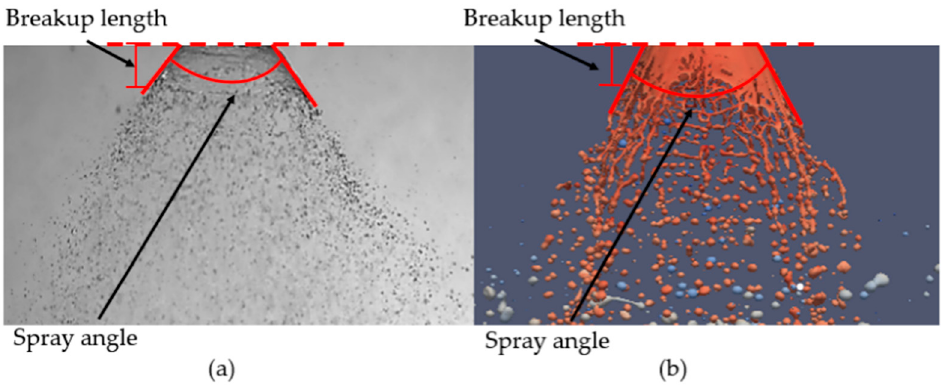
Figure 5. Comparison of an experimental image ( a ) and a simulation image ( b ) .